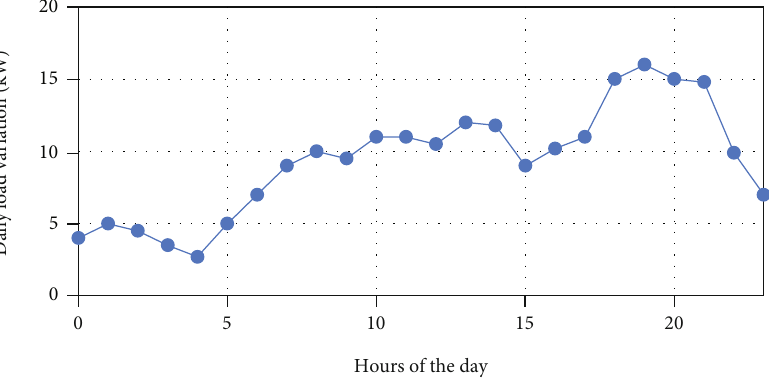
Figure 3: Daily load variation for the luxury house used as a research object.